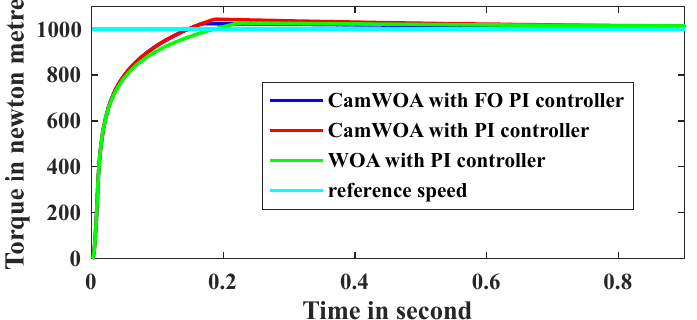
Figure 11. Comparison of tracking of speed with reference speed by MWAO and WOA controller.